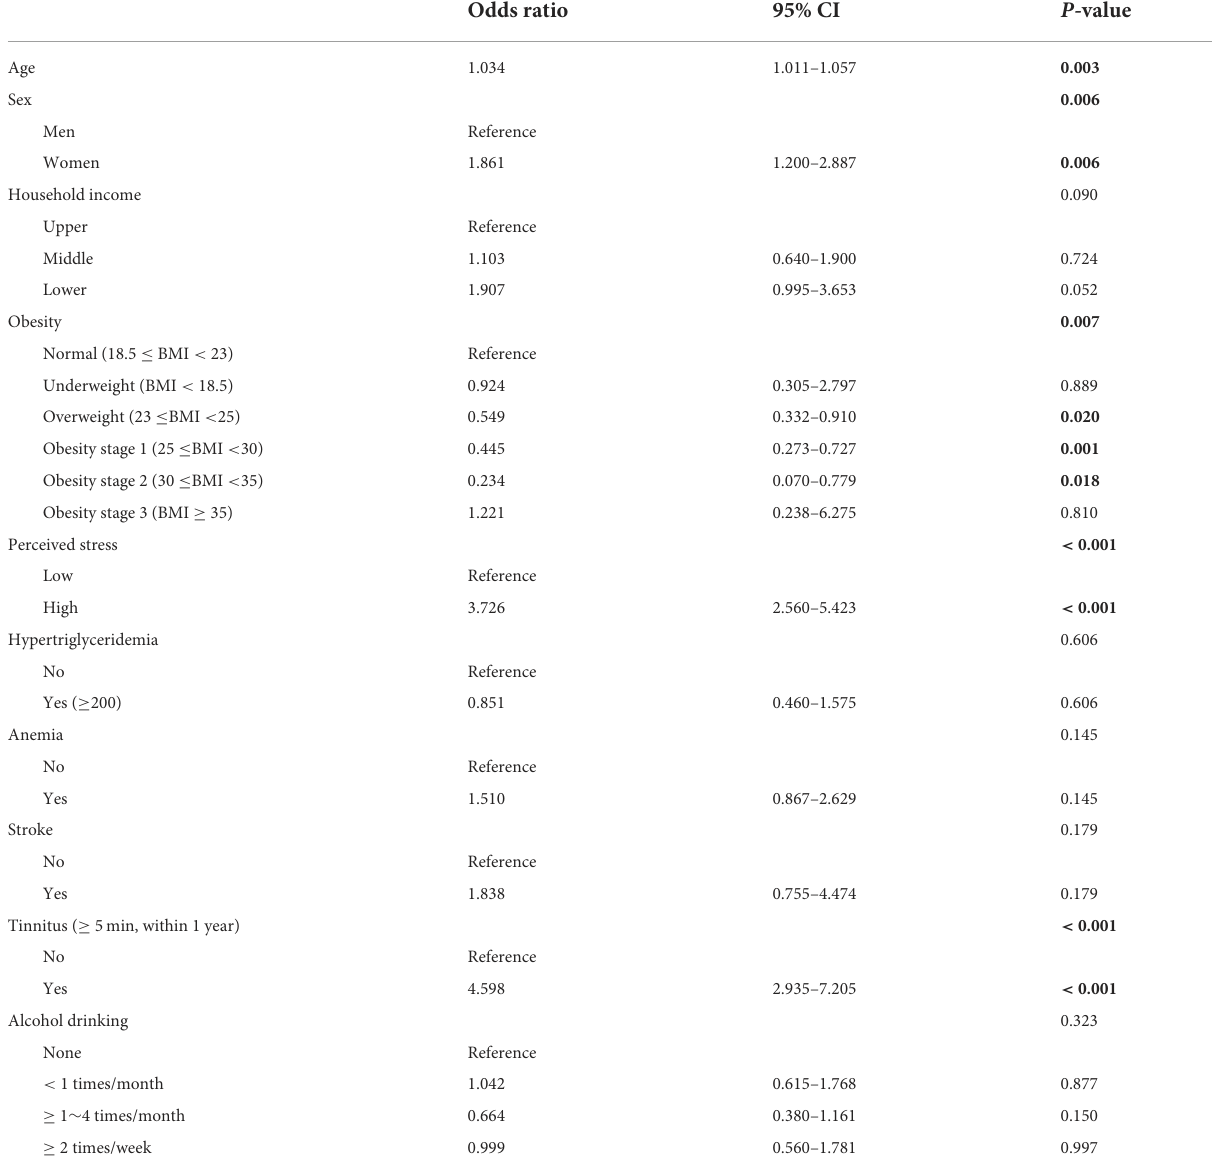
TABLE 4 Multiple logistic regression analysis for chronic